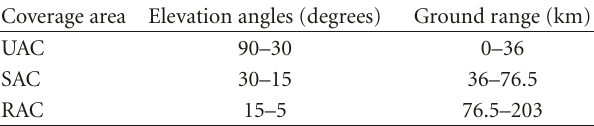
Table 1: HAPS coverage